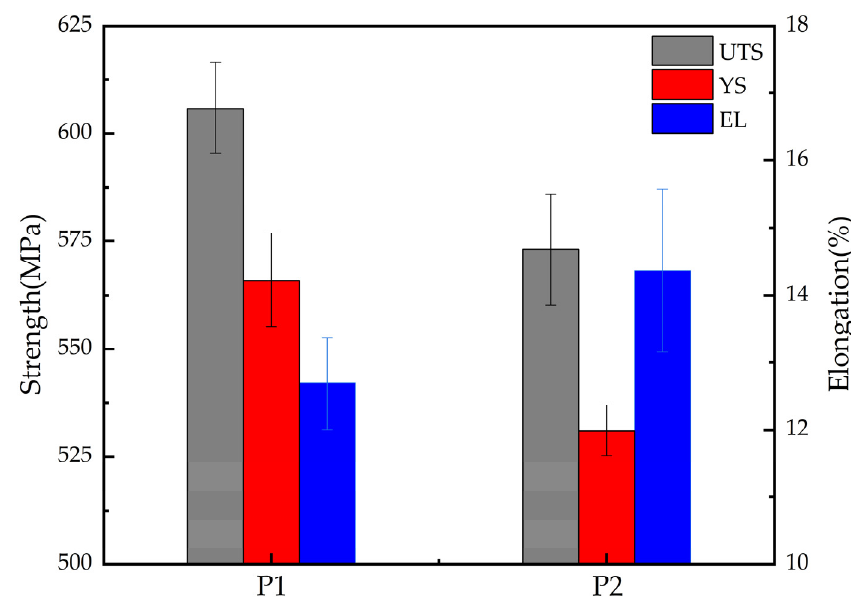
Figure 9. Comparison of mechanical properties of sprayed 2195 alloy after P1 and P2.